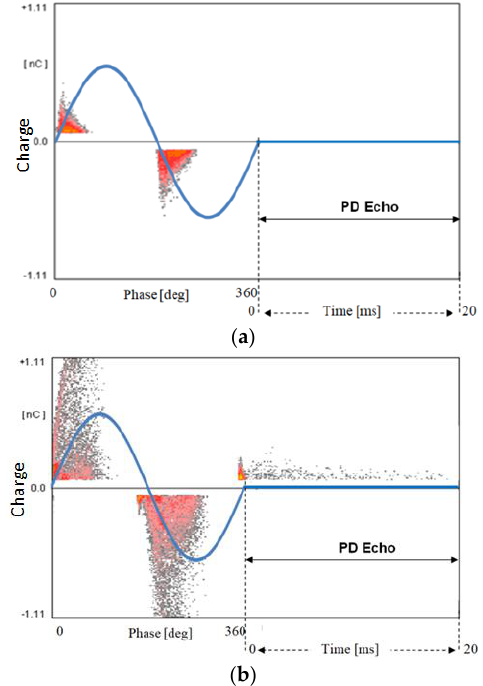
Figure 6. The PD pattern recorded in the chopped sequence with the introduced delay time t d = 20 ms ( ff = 1:2), in void embedded in glass, at ( a ) 7.5 kV 1.2 U 0 , and ( b ) with PD Echo at 2.4 U 0 .